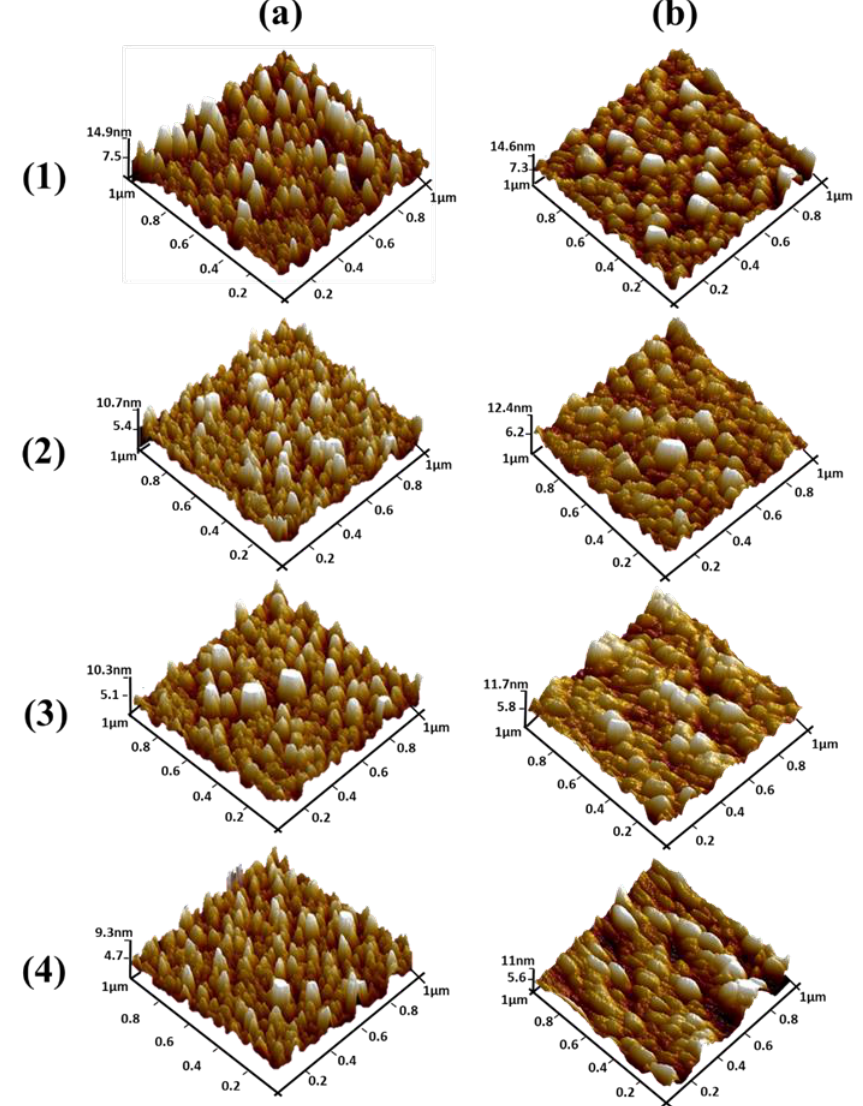
Figure 6. Atomic force microscopy (AFM) images of ( a ) non-annealed and ( b ) annealed ZnO seed layers with thicknesses of (1) 100, (2) 50, (3) 10, and (4) 5 nm. Table 4. Roughness values of different thicknesses of non-annealed and annealed ZnO seed layers. Thickness of Seed Layer